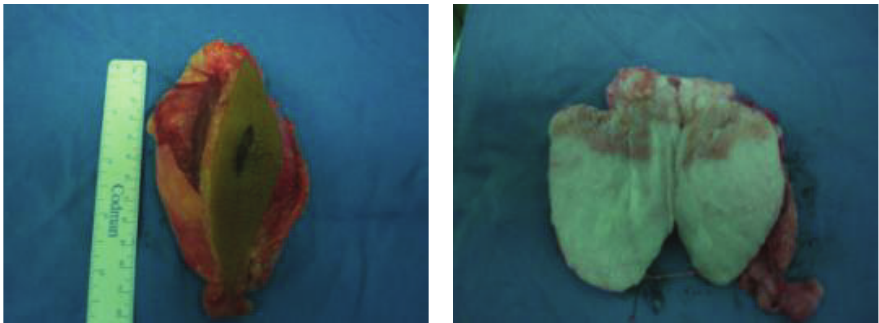
Figure 4: Macroscopic pictures of the tumour after surgical excision in Case